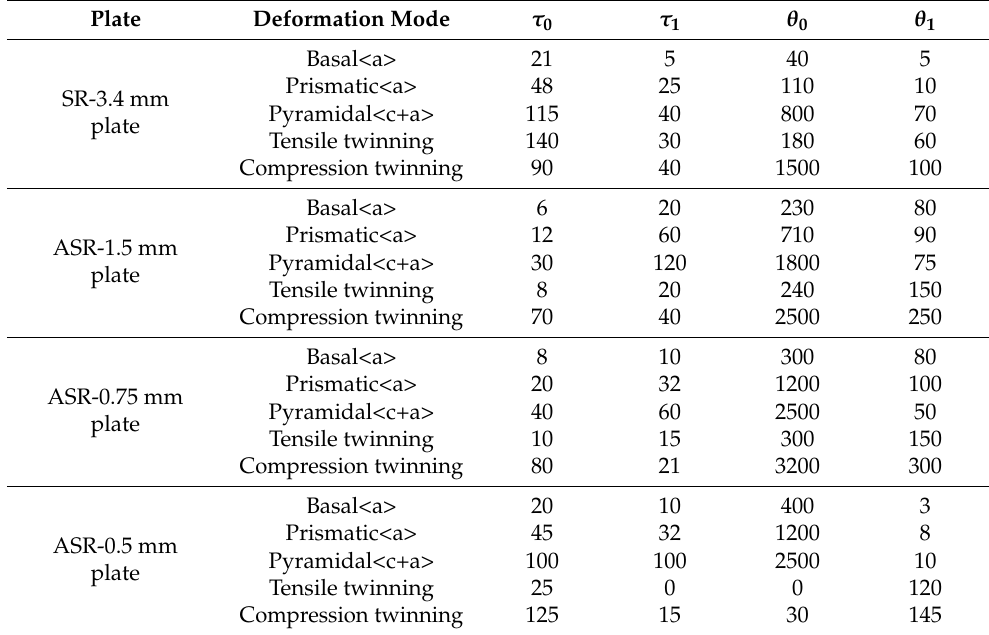
Table 5. VPSC simulation for the best fitting hardening parameters in asymmetric rolling.